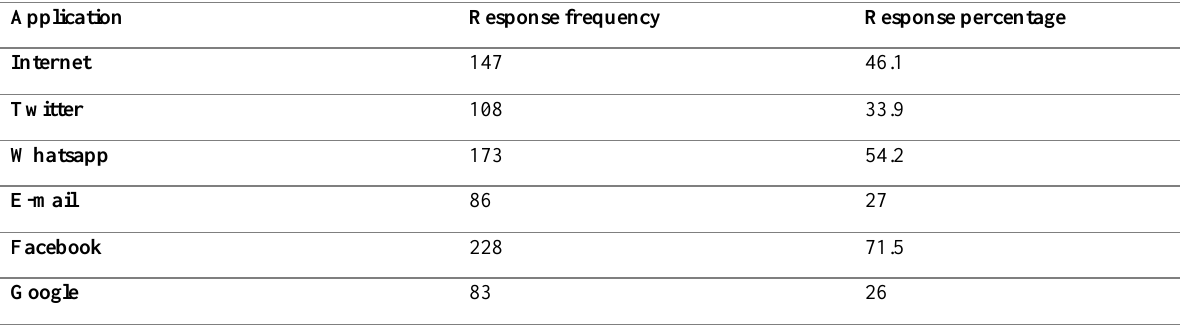
Table 2: Response on conversant